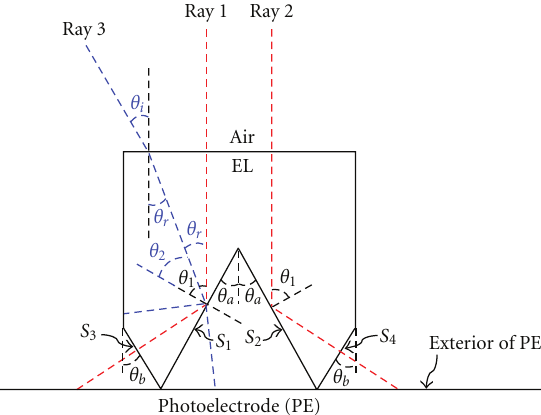
Figure 2: Proposed EL architecture.